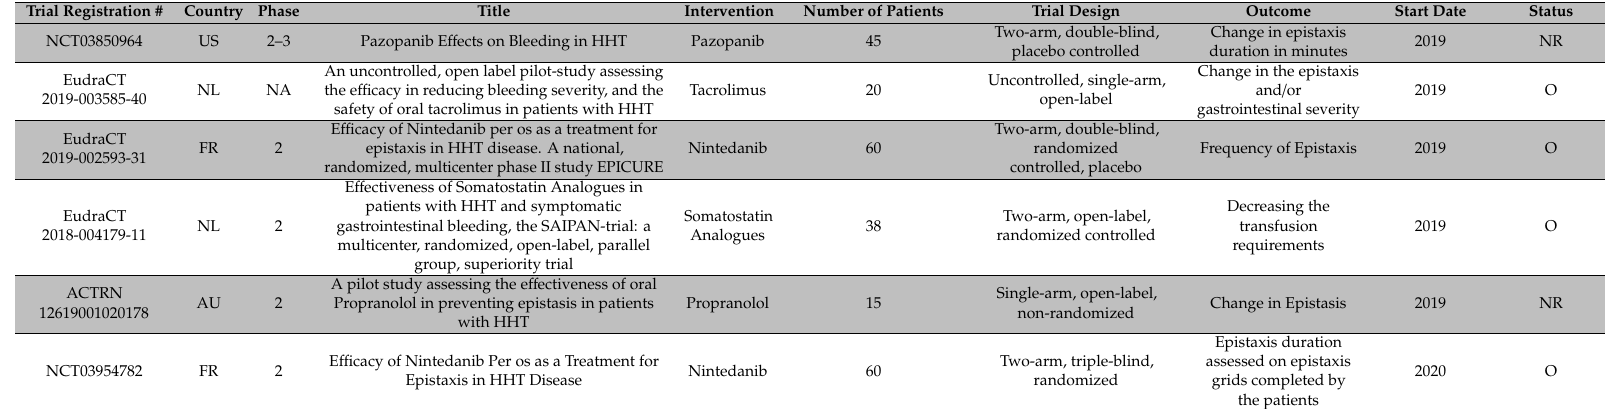
Table 2. Compilation of the Recruiting, Ongoing, or Unknown HHT interventional clinical trials registered at the EU Clinical Trials Register (EudraCT) (https: // www.clinicaltrialsregister.eu), the U.S. National Library of Medicine (NCT) (https: // clinicaltrials.gov), and the Australian New Zealand Clinical Trials Registry (ACTRN) (http: // www.anzctr.org.au / Default.aspx). Only interventional trials where a therapeutic drug was tested are listed. Abbreviations: Countries: AR (Argentina); AU (Australia); CA (Canada); FR (France); IT (Italy); NL (Netherlands); US (United States of America). Phase: NA (Not Applicable). Status: R (Recruiting); O (Ongoing); U (Unknown). Outcome: ESS (Epistaxis Severity